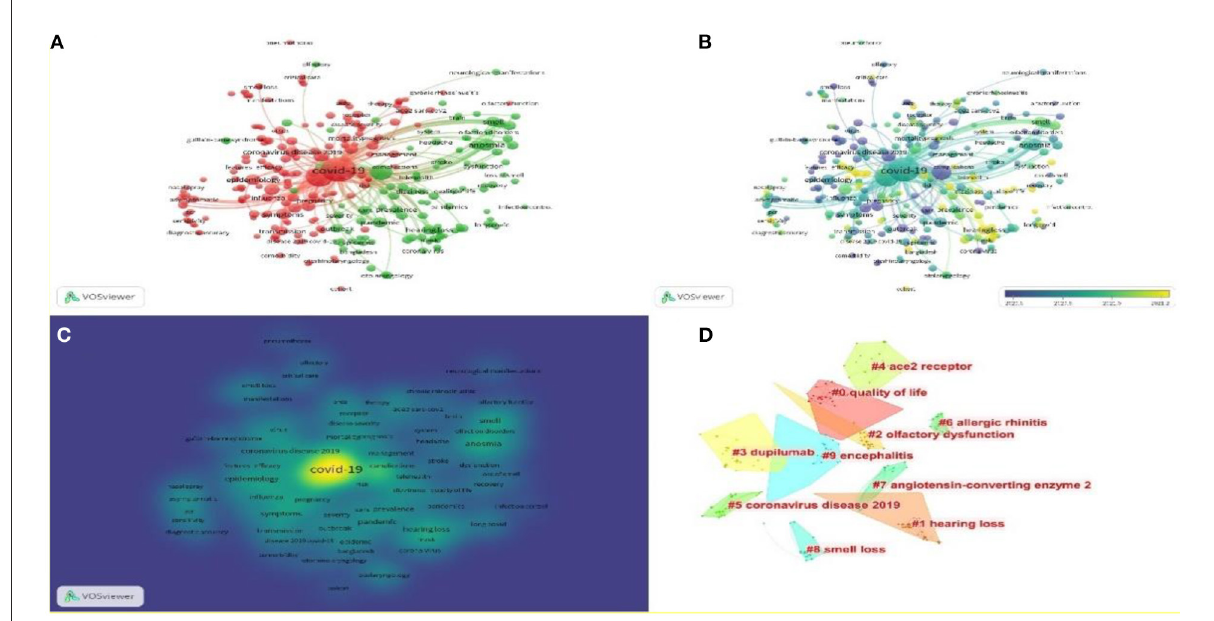
FIGURE8 Bibliometric analysis of keywords for COVID-19 research in otorhinolaryngology. (A) Keywords distribution. (B) Map showing trending themes from June 2020 to February 2021 based on keywords. From purple to yellow, the indicator reflects the current status of publications. To determine how frequently two objects appear together, the distance between two circles is plotted against the frequency of appearance. (C) The density of keywords on a map. (D) Analysis of keyword clusters (the order is from #0 to #9; The smaller the number, the more keywords the cluster contains, so the more attention it